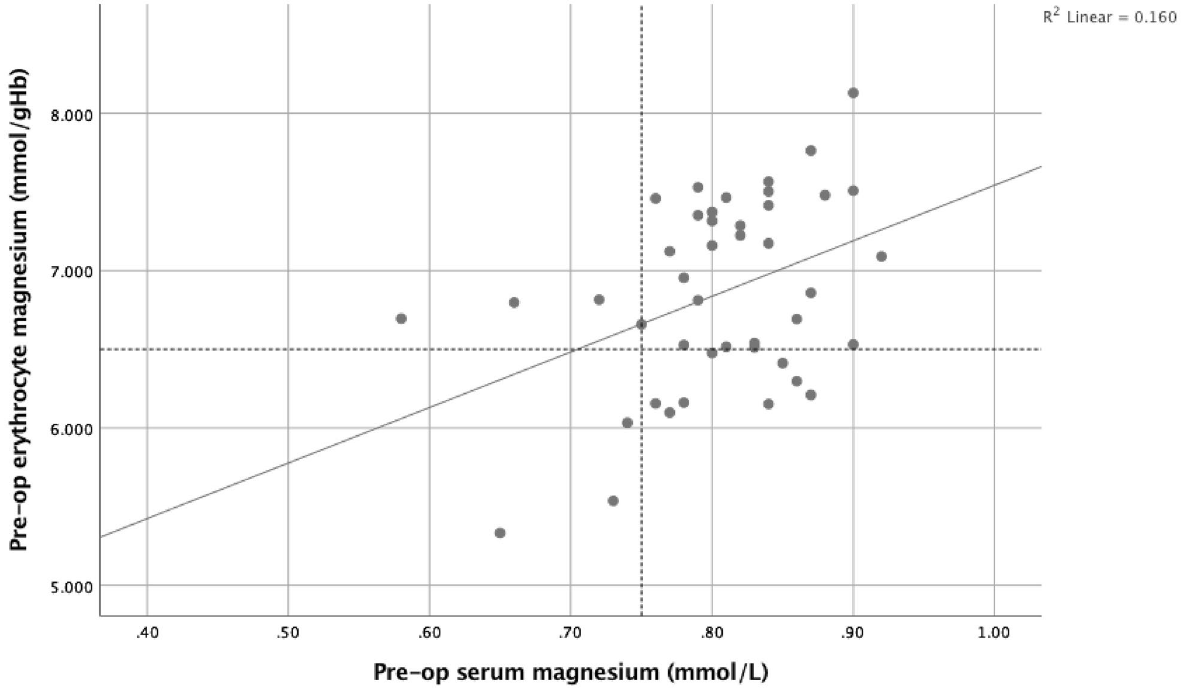
Figure 3. The relationship between pre-operative erythrocyte magnesium (mmol/gHb) and serum magnesium concentrations (mmol/L).